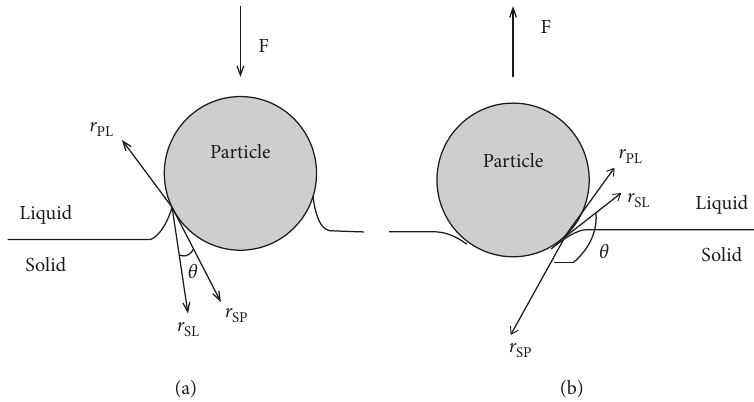
Figure 5: Reaction model of interface between solid phase and liquid phase. (a) θ < 90 ° (b) θ > 90 ° .